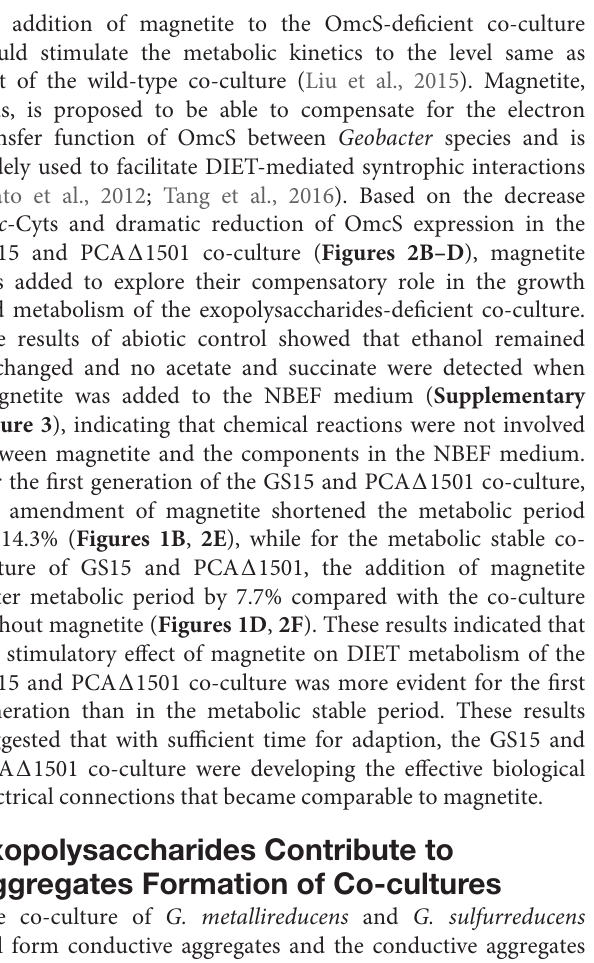
Frontiers in Microbiology |